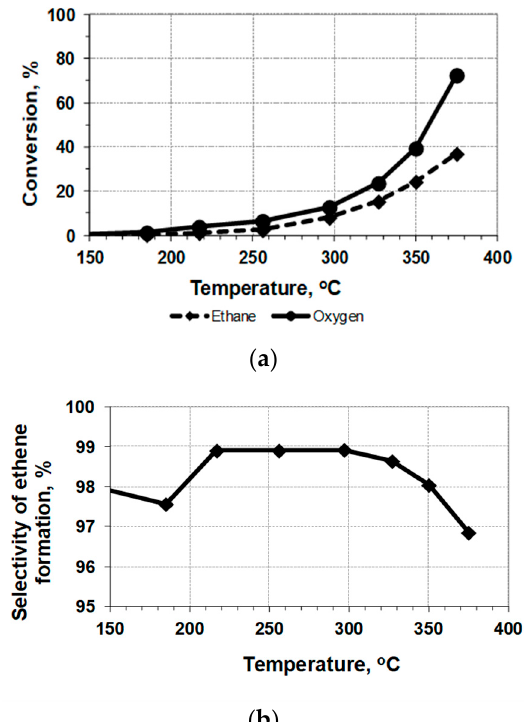
Figure 4. ODE with mw -heating of the same sample Mo-V-Te-Nb-Ox (0.37 g; 0.3 cc) diluted by quartz (1/1): ( a )—conversion of reagents; ( b )—selectivity of C 2 H 4 formation; gas mixture